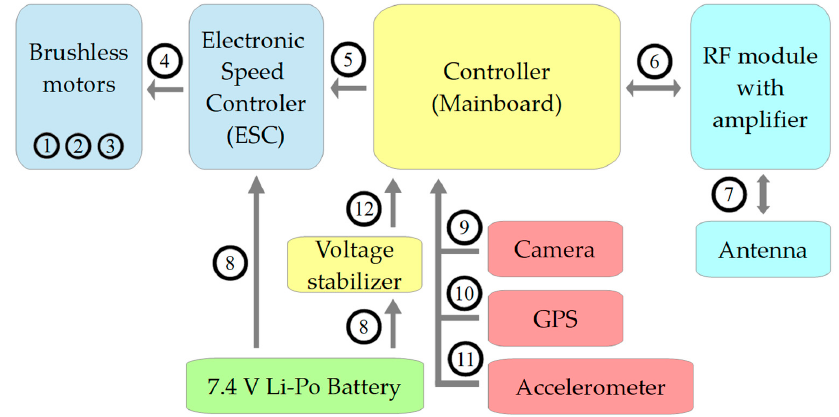
Figure 2. Block diagram of the drone (the same peripherals are the same block color) with numbered measurement points.